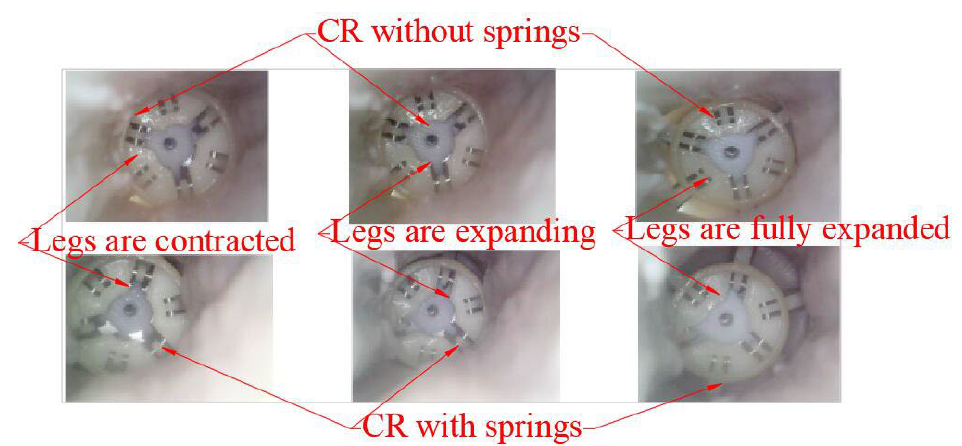
Figure 8. Comparison of the effects of the CR on the expansion of intestinal folds (with or without springs).